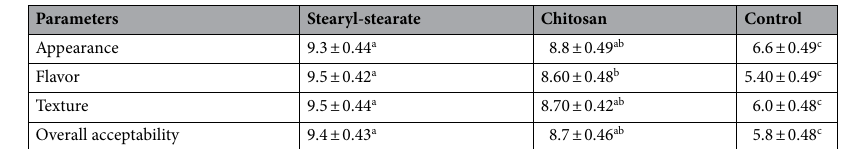
Table 3. Sensory evaluation of stored tomatoes at (23 ± 1 °C/65 ± 2% RH). Data are expressed as mean ± SD values given represent means of three determinations; the different letters in the same raw are significant (p ≤